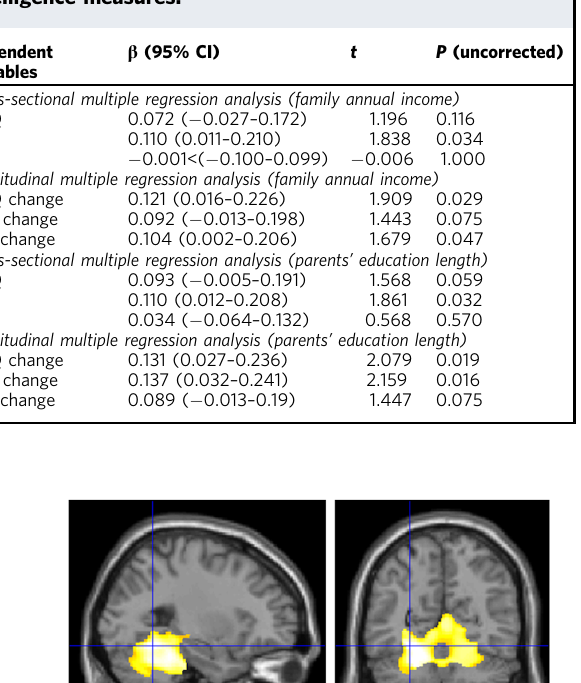
insigni fi cant. This was done to investigate the possibility that